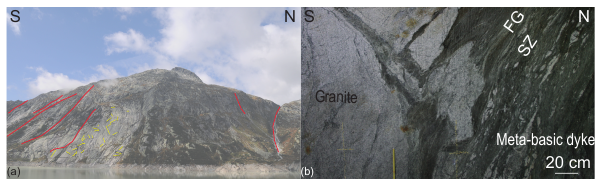
Figure 11. (a) Mountainside with incisions and exfoliation joints. (b) Detailed picture of underground outcrop showing outcrop con- ditions and key structural features: a ductile shear zone (SZ) and a fault gouge